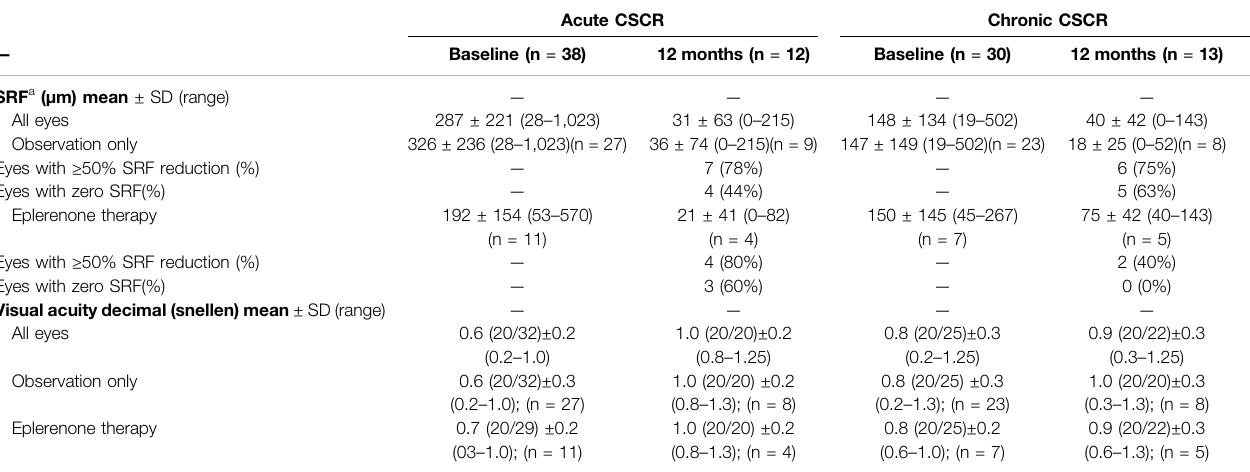
TABLE 1 | Baseline characteristics and outcomes at 12 months of eyes with acute and chronic CSCR. Acute CSCR Chronic